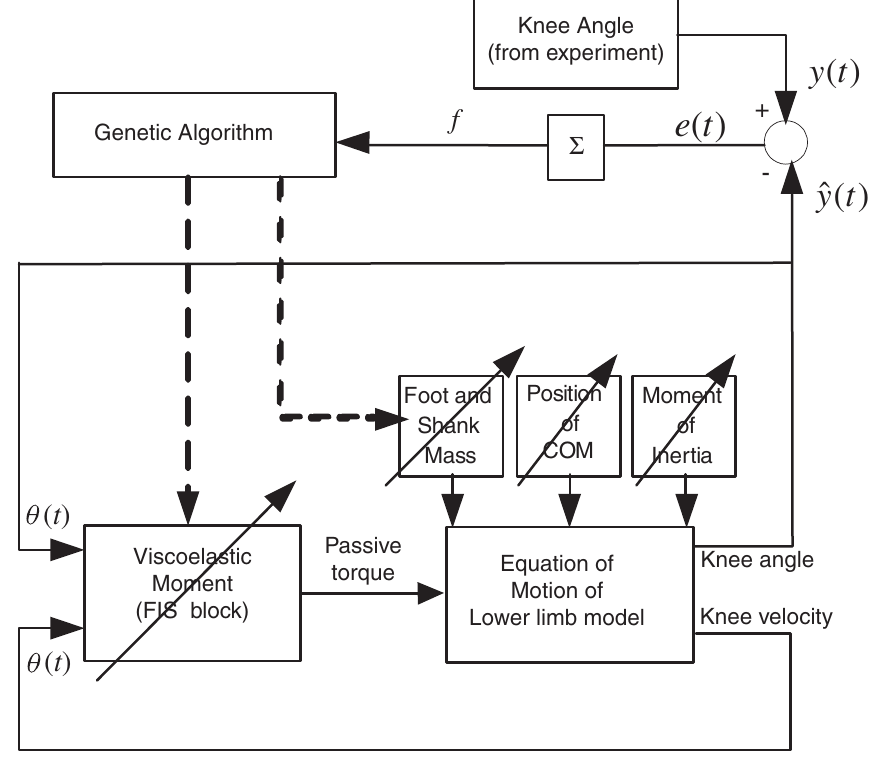
Fig. 4. Optimization of passive viscoelasticity and anthropometric inertia